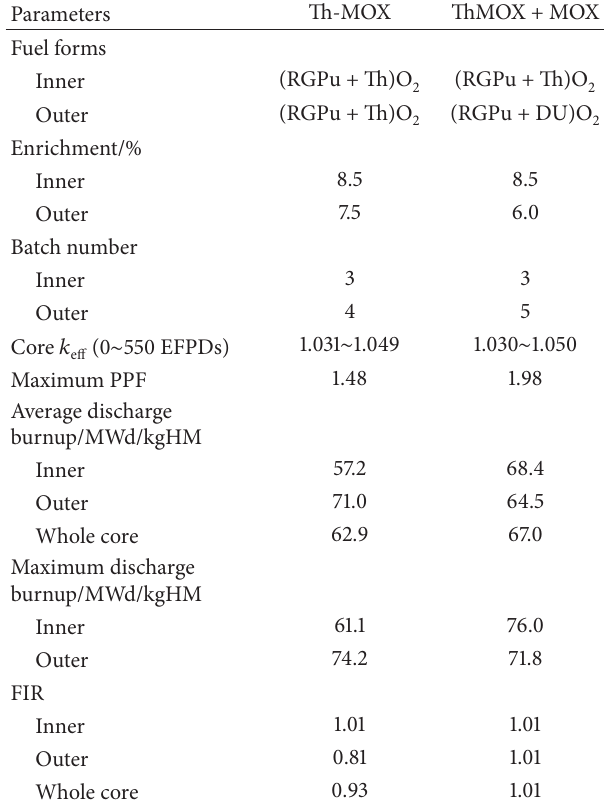
Table 4: SCFR core parameters with different fuel